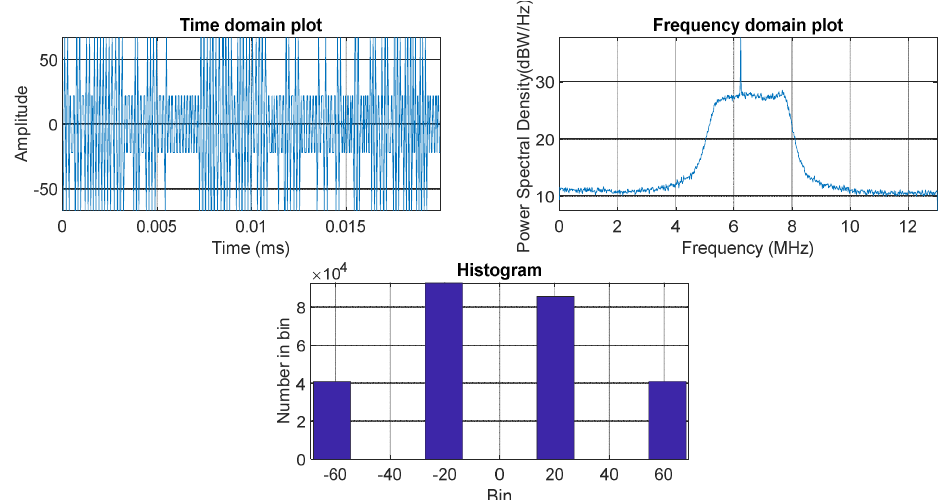
Figure 6. Sampled signal characteristics (raw collected GNSS receiver data) .